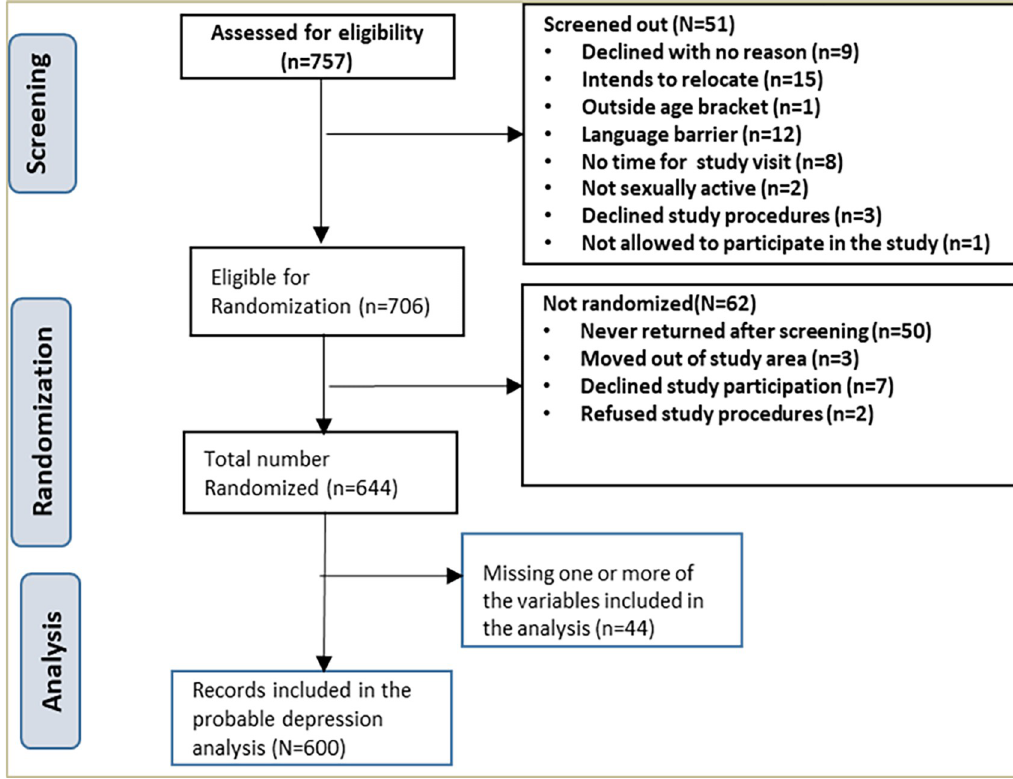
Fig 1. Screening profile of study